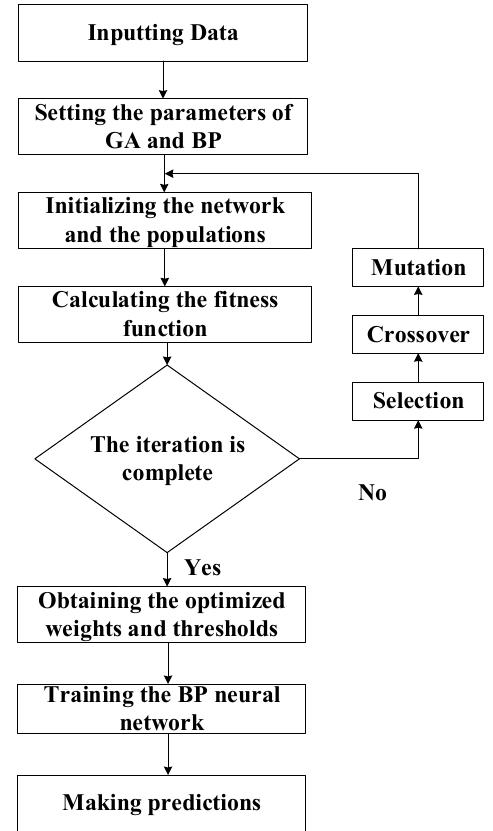
Figure 9. The flow of the GA-BP neural network algorithm.